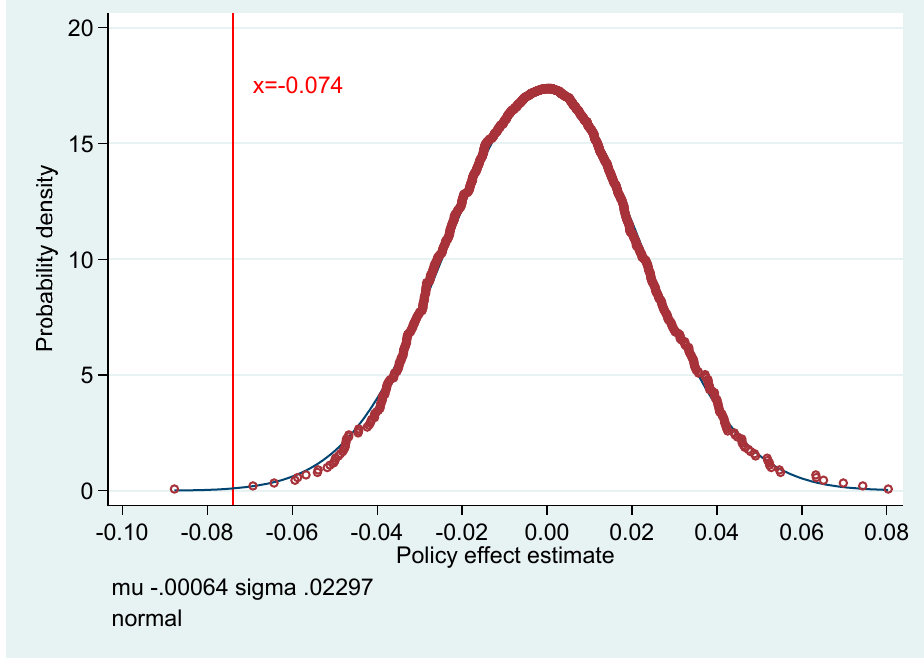
Figure 3. Placebo test of the experimental group.